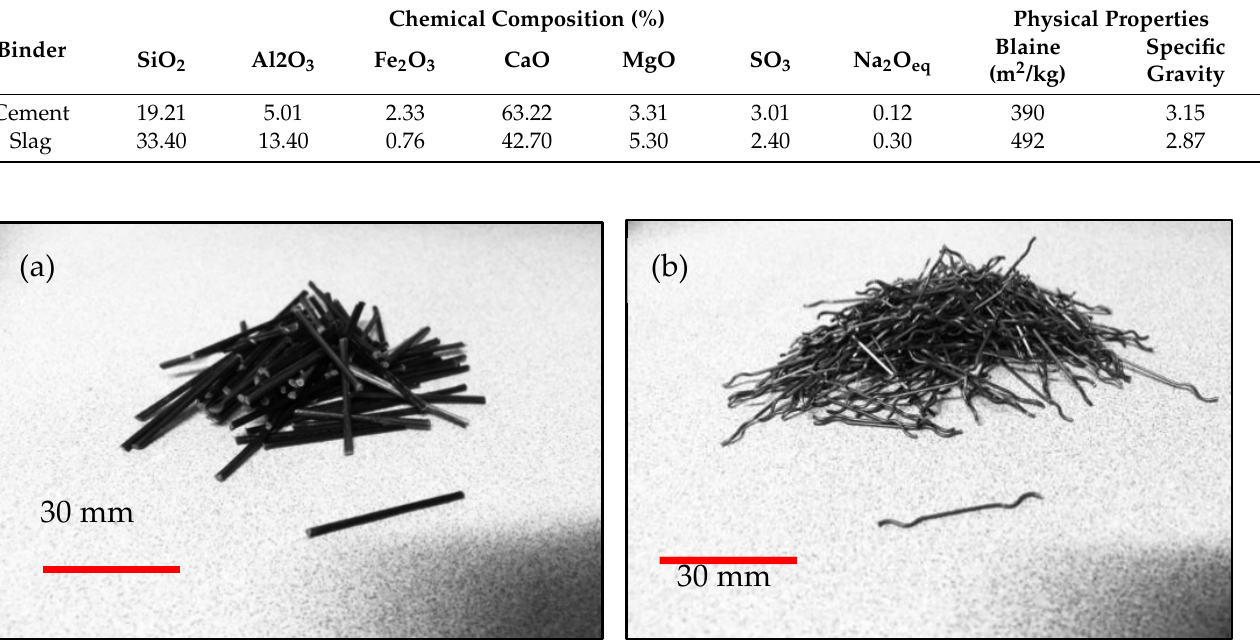
Table 1. Chemical and physical properties of GU cement and slag.